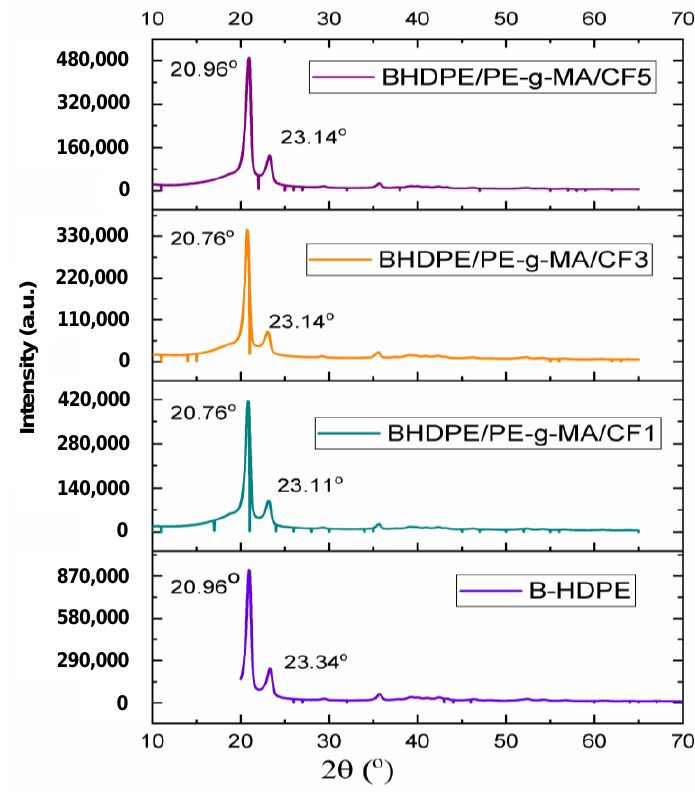
Figure 3. XRD patterns of B-HDPE and biocomposites.